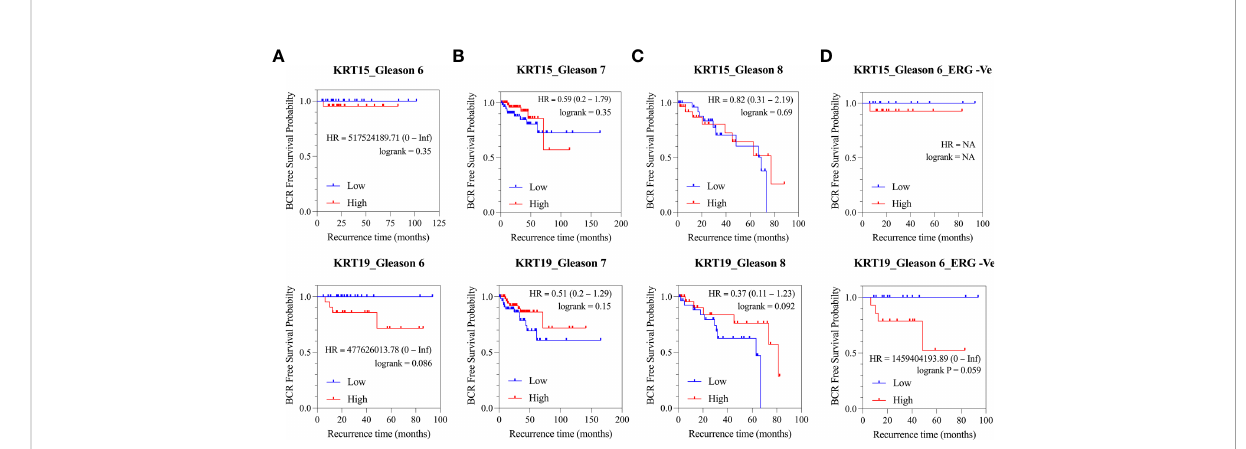
FIGURE 4 Association of KRT15 and KRT19 expression with risk of BCR in PCa patients (TCGA cohort). (A) Gleason six patients ’ category. (B) Gleason seven patients ’ category. (C) Gleason 8+ patients ’ category. (D) Gleason six and ERG fusion negative patients ’ category.